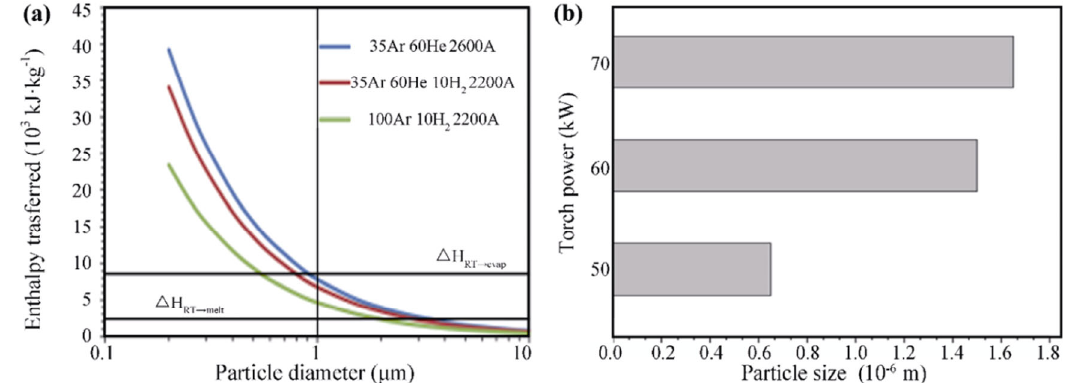
Fig. 72 Results of heat transfer calculations in torch nozzle: (a) enthalpy transferred to spherical particles as a function of particle diameter (all results for three investigated plasma parameters: 35Ar 60He 2600A, 35Ar 60He 10H 2 2200A, and 100Ar 10H 2 2200A) and (b) effect of power on evaporated particle size. Reproduced with permission from Ref. [408] for (a), © Springer Science+Business Media New York 2014; Ref. [409] for (b), © ASM International